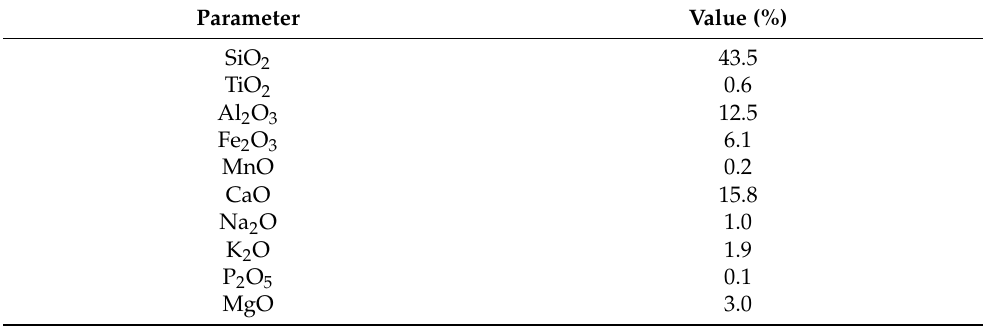
Figure 2. The washed-off silt during limestone production is stored at S.A.P.A.B.A. s.r.l.’s sedimentation lakes, where it is collected and processed for further use [6]. Table 1. Chemical composition of uncalcined silt. Table 1. Chemical composition of uncalcined silt.